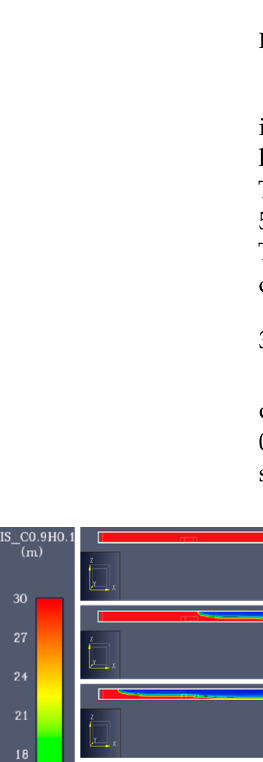
Figure 10. Changes in the longitudinal center section of visibility: ( a ) 0.5 m/s; ( b ) 3.6 m/s.